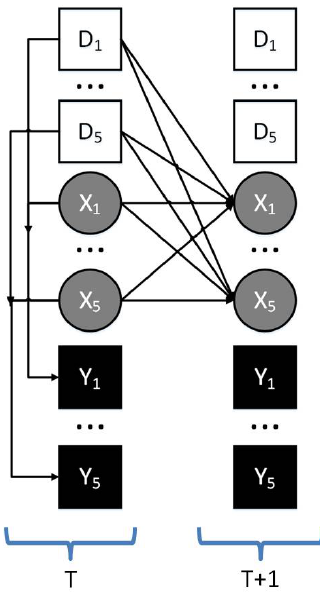
Figure 4. The Dynamic Bayesian Network (DBN) for